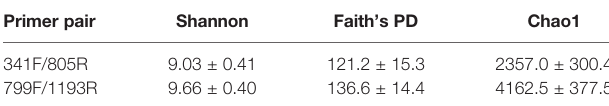
TABLE 3 | Alpha diversity measure (Mean ± SD) of soil bacterial communities using two different primer pairs. Primer pair